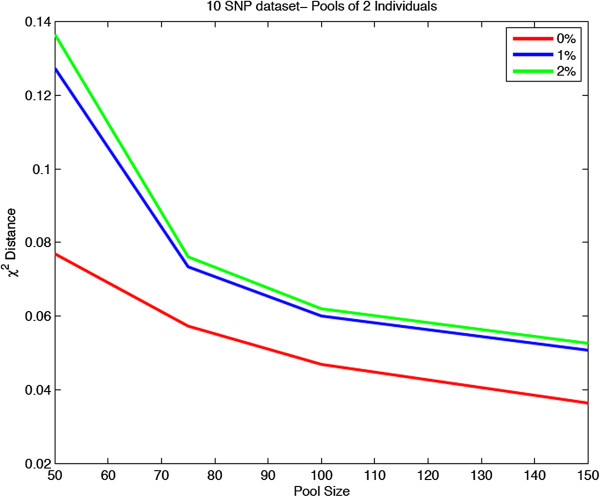
Measures of performance of ADM applied to the HapMap dataset with missing observations.